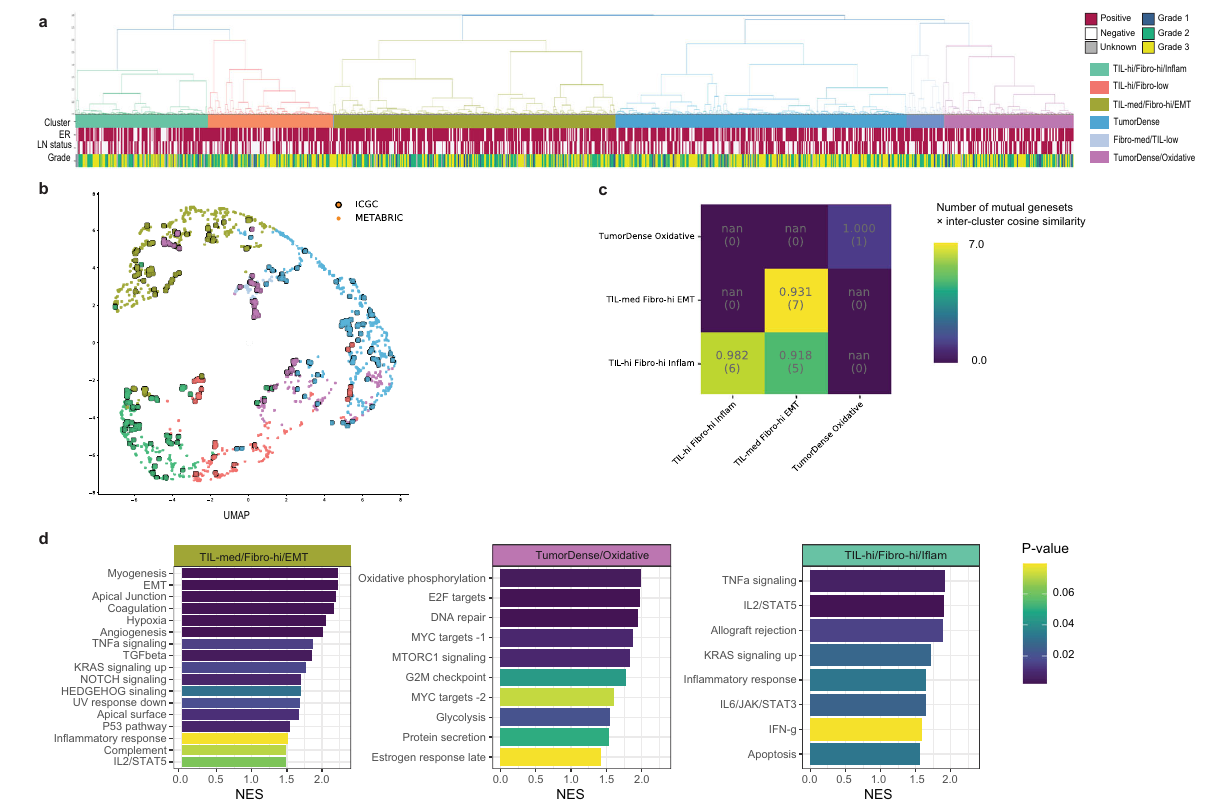
Fig. 4 Spatial clusters in METABRIC cohort similar to ICGC cohort. a Dendrogram of the hierarchical clustering of the METABRIC cohort ( N = 998) with annotated clinical parameters. b Two-dimensional representation of the six measurements that is acquired by applying a UMAP transformation for the ICGC and METABRIC clusters combined. c Heatmap of the cosine similarity of the mutual gene sets between clusters of the ICGC and METABRIC cohort, FDR q -value < 0.25. d The normalized enrichment score (NES) for the hallmarks of cancer gene sets for each of the six spatial clusters in METABRIC (ER + HER2 − samples only, N =